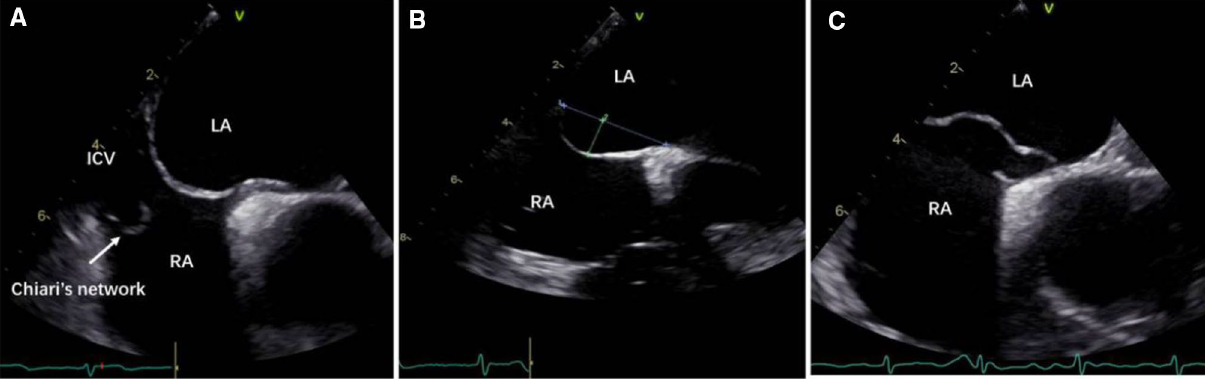
excursion from the midline into the right or left atrium. C A moving and floppy septum defined the maximum mobility of the interatrial